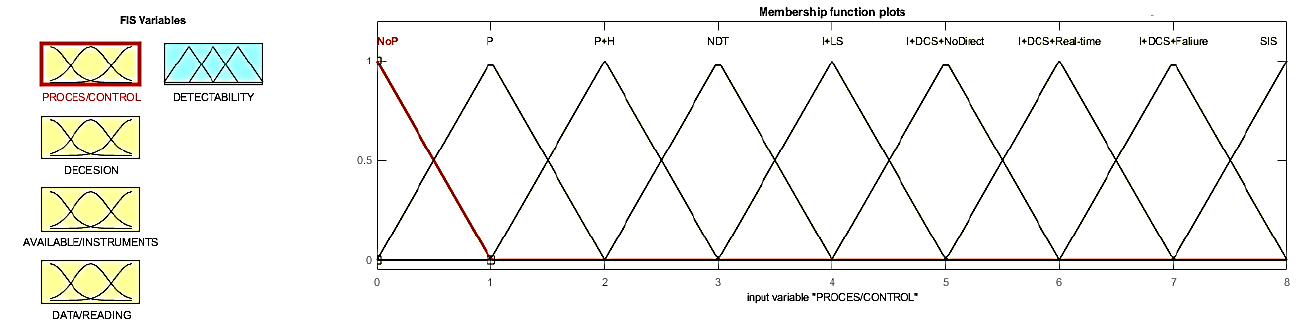
Table 2. Fuzzy set of output variables after the first stage of fuzzy logic systems that represent inputs to fuzzy RPN FIS.